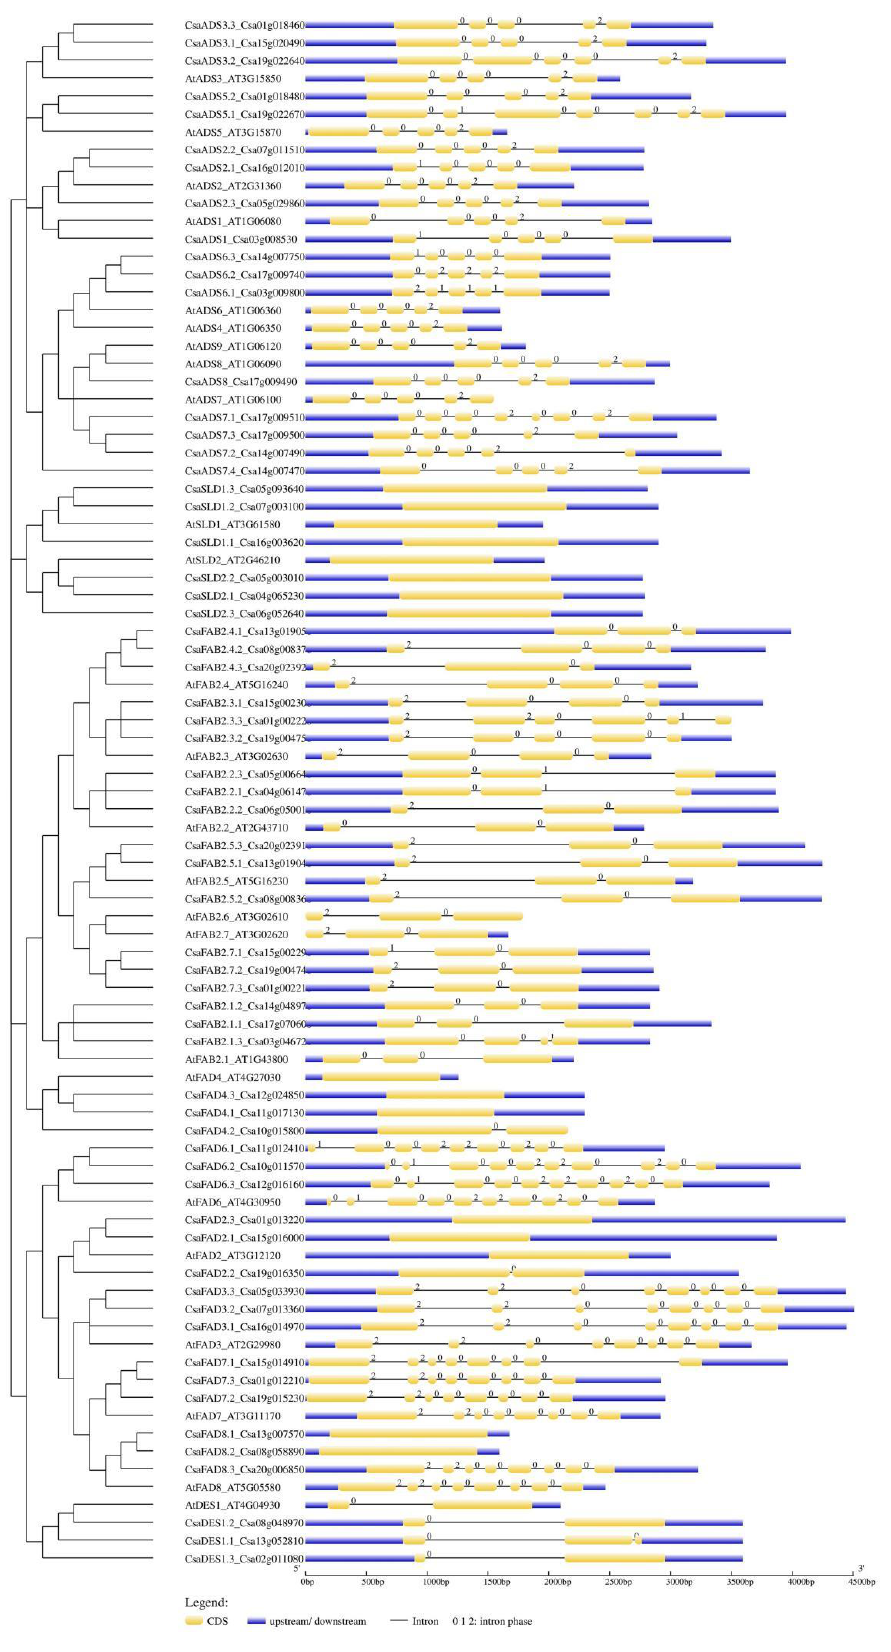
Figure 3. Gene structure of fatty acid desaturases in A. thaliana and C. sativa. Numbers indicate the intron